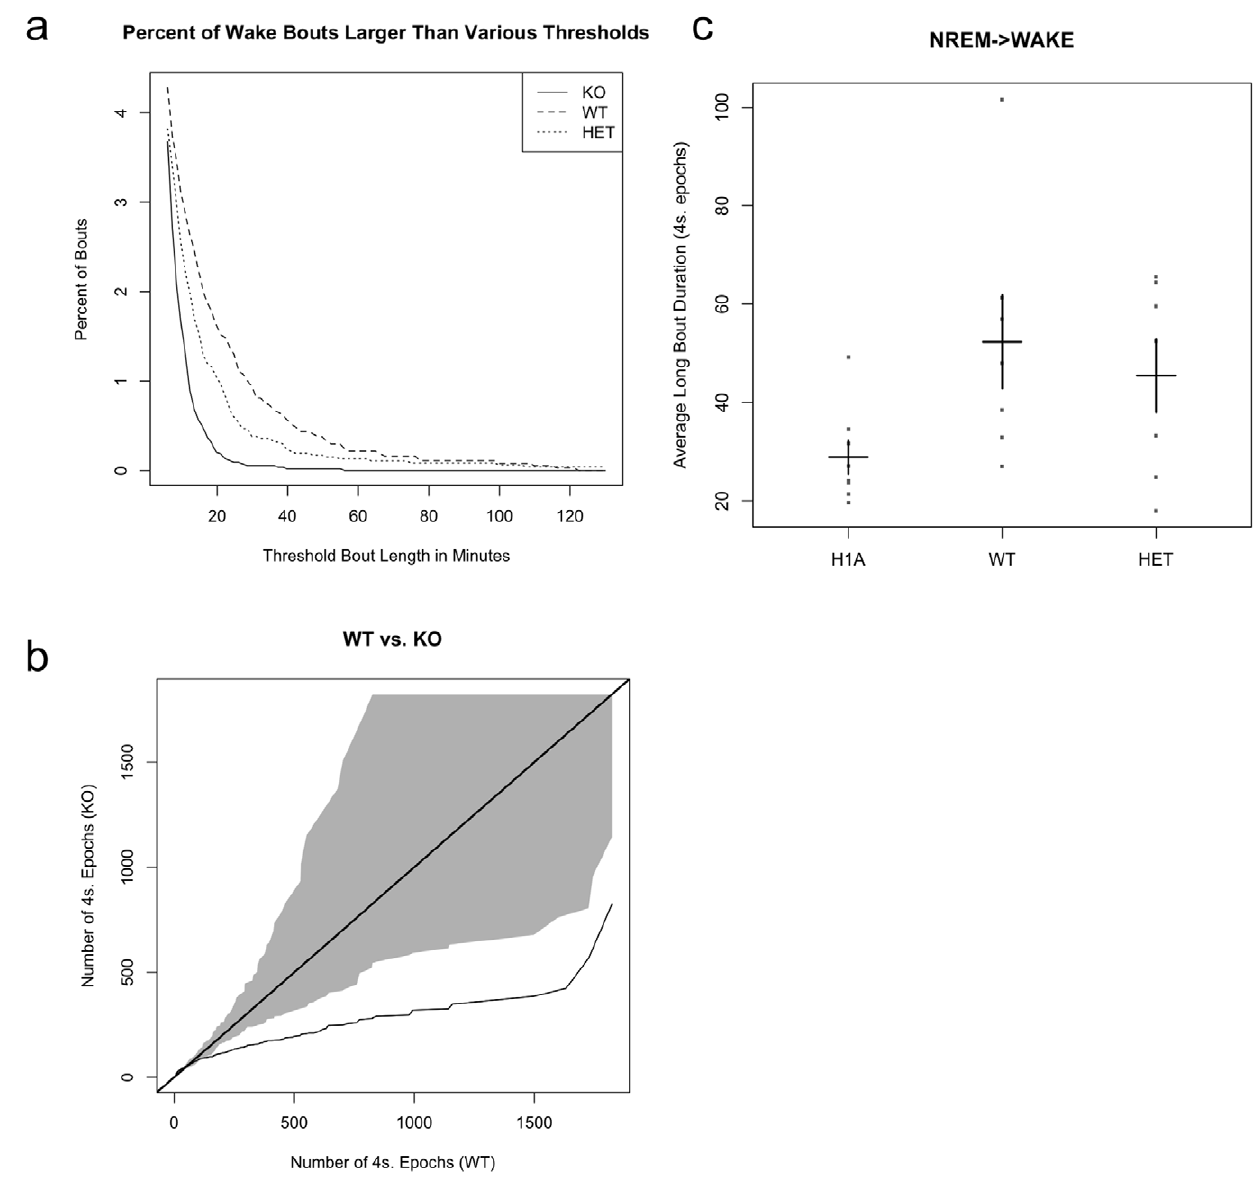
Figure 4. Loss of Homer1a reduces the ability to sustain long wake bouts. A) Percent of wake bouts larger than various thresholds for Homer 1a knockout (KO), wildtype (WT) and heterozygote (HET). The plot shows that for any given bout length threshold, WT and HET have a larger fraction of wake bouts that meet or exceed that threshold as compared to H1A. The number of bouts on the Y axis is small since most bouts are short, whereas the long bouts make up more of the actual duration of wakefulness. B) Q-Q plot for WAKE bout durations given as number of 4- second epochs for Homer1a knockout (KO) (Y axis) and wildtype (WT) mice (X axis). Identical distributions would fall on the line of identify; the grey area on the plot is the estimated variance around the line of identity (null region). The plot show that the Q-Q line falls outside of the grey null region indicating that the bout durations distributions for KO and WT are statistically different from one another. In particular, WT mice have much longer bouts of wakefulness than KO. C) Plot showing that the distribution of the average bout duration slab size in the Homer1a mutant, WT and heterozygote during NREM to wake period. The average slab (composed of long bouts) size is reduced in the Homer1a KO.